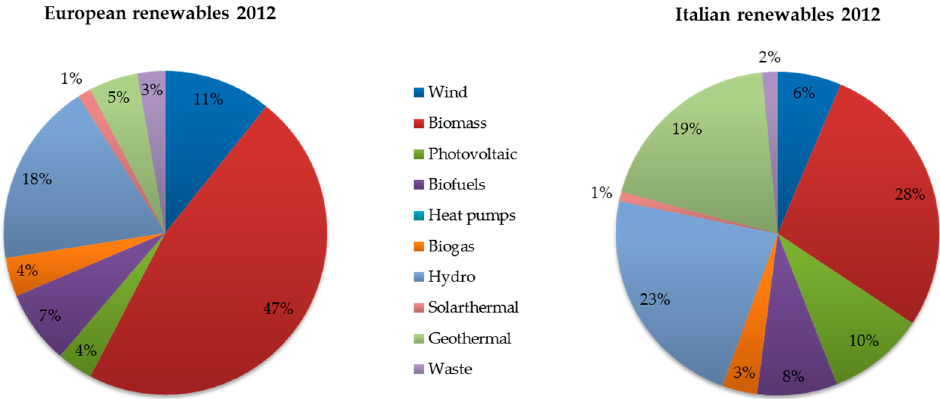
Figure 1. European and Italian renewables in 2012 [4].